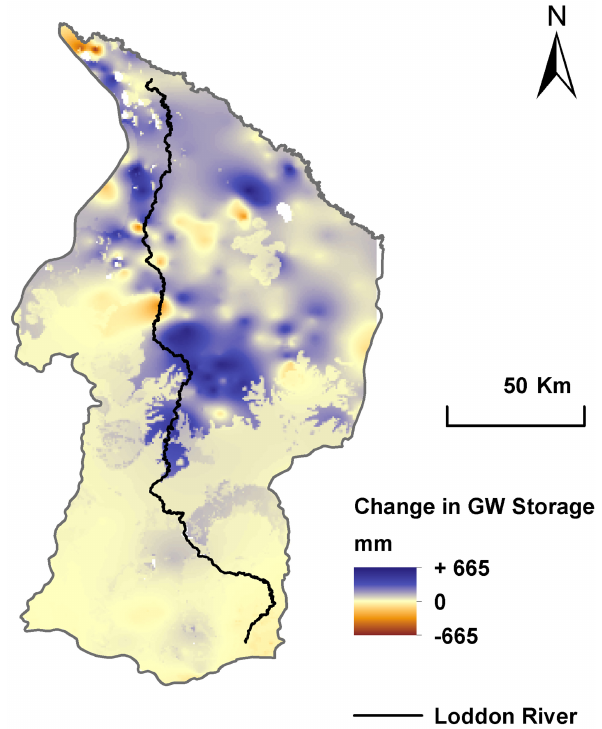
Fig. 10. Change in storage at a catchment scale estimated from in- terpolated bore responses on 1 November 2010 and 31 March